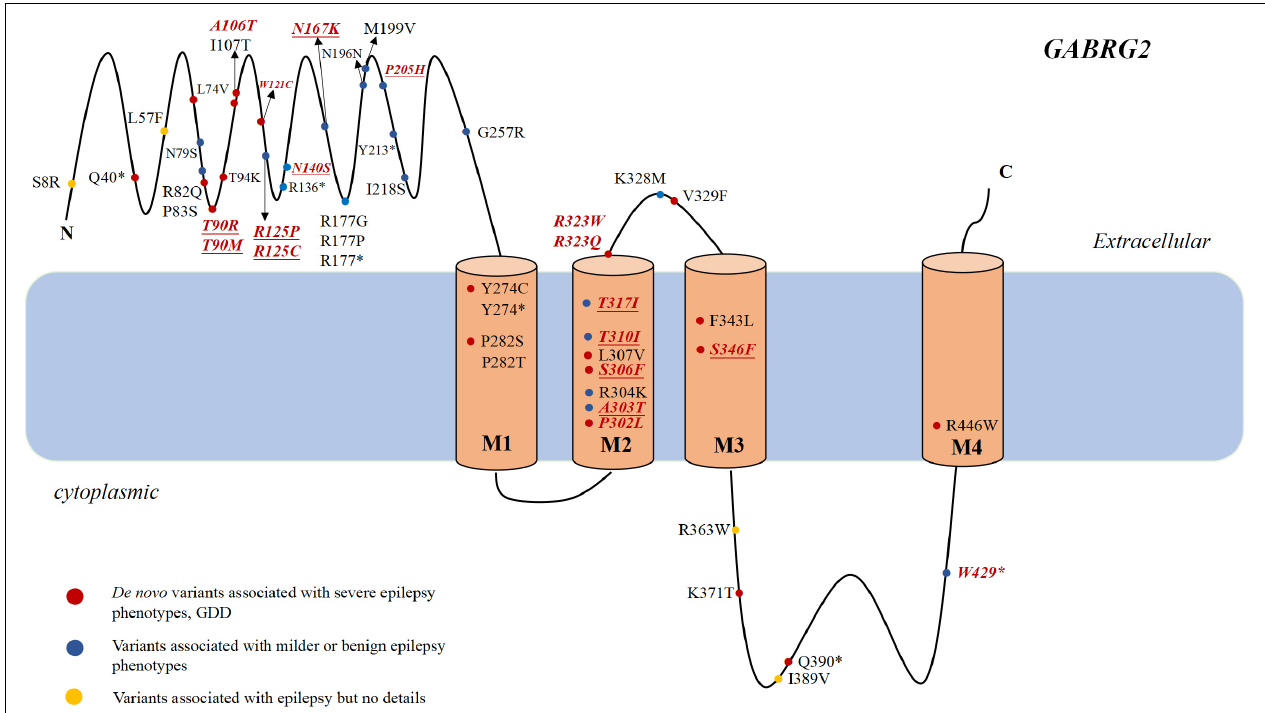
FIGURE 1 | The genotype and phenotype of GABRG2 pathogenic variants in patients with epilepsy. Representation of the GABA A receptor protein structure and the location of GABRG2 variants previously described in the literature (marked in black) and identified in our cohort (marked in red and italics). The novel variants reported for the first time in the present study are indicated in underscored. The red dots indicate severe phenotypes, including epileptic encephalopathy and developmental delay along with epilepsy. The blue dots indicate mild phenotypes, including febrile seizure plus and GEFS+. The yellow dots indicate the variants associated with epilepsy but no details are available. *Represents the nonsense